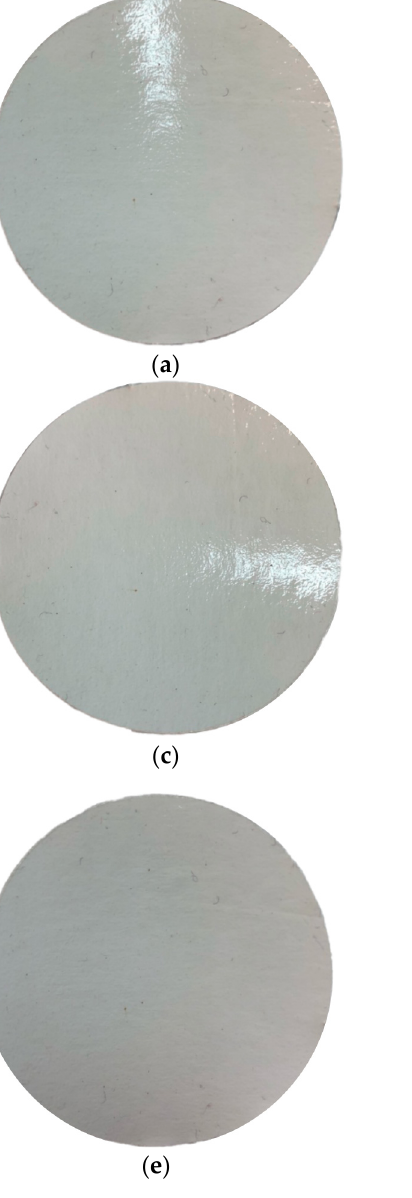
( f ) Figure 5. SEM images of the surface of the selective membrane layer before: ( a ) PDecMS; ( c ) PHeptMS; ( e ) MDK-3 and after one month of contact with ABE-fermentation broth: ( b ) PDecMS; ( d ) PHeptMS; ( f ) MDK-3. Before contact of the membranes with the ABE-fermentation mixture, the surfaces of the selective layer were smooth and homogeneous (Figure 5a,c,e). After one month of con- tact with the ABE-fermentation medium, deposits were observed on the surfaces of all the studied membranes (Figure 5b,d,f). To determine the elemental composition of the de-